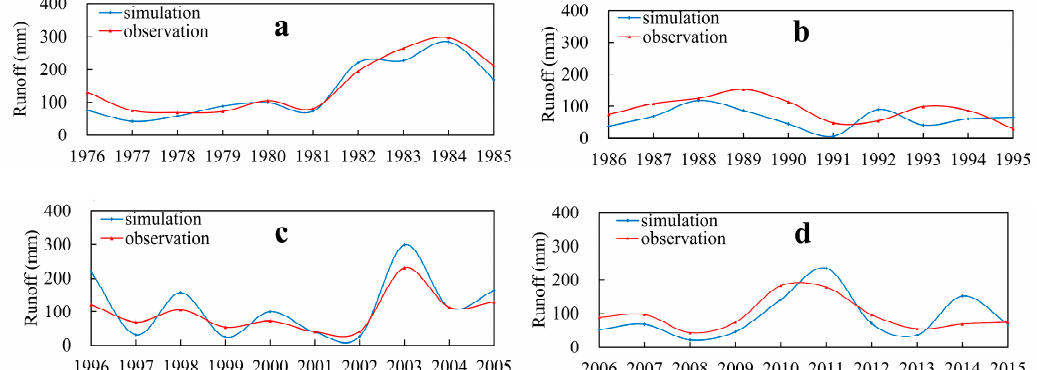
Figure 6. Comparison between the simulated and observed annual runoff values for scenarios ( a ) S1, ( b ) S2, ( c ) S3, and ( d ) S4. Table 5. Comparison between the simulated (natural) and observed mean discharge during the dry season and the wet season under scenarios S1, S2, S3, and